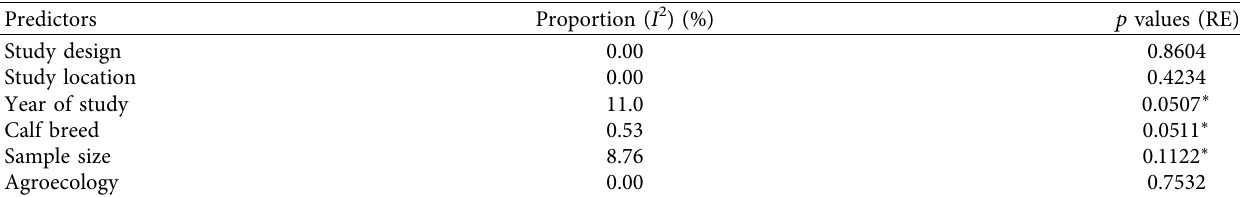
Figure 3: Forest plot visualizing the varying calf mortality prevalence reported for each study included publication in the meta-analysis. Weightage given to each included publication by both RE and FE models has been shown for rigorous comparison. Table 3: Proportion of the between-study variance explained ( I 2 ) by each variable considered in meta-regression on the prevalence of calf mortality in Ethiopia.